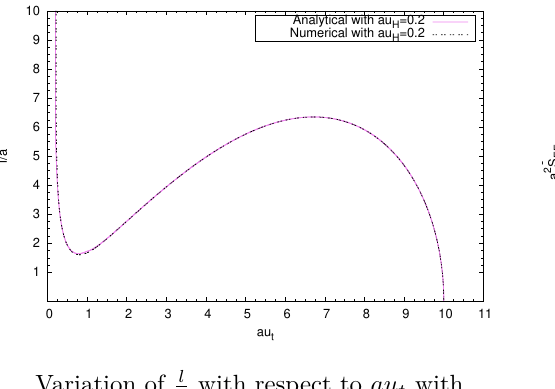
Figure 7 . In the left we have shown the variation of l have presented the variation of a 2 ¯ S EE with respect to l